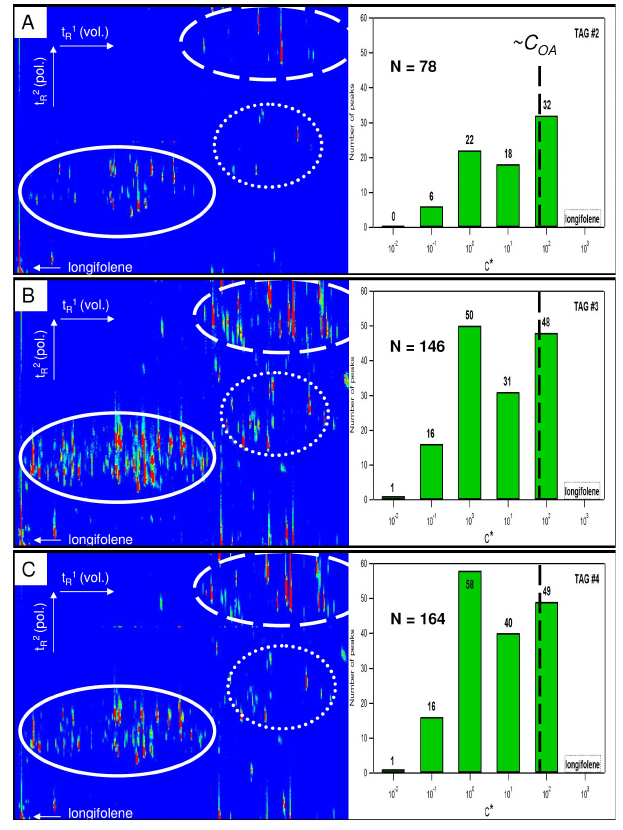
Fig. 6. GC × GC chromatograms and the number of peaks in each C ∗ bin in samples (A) TAG #2; (B) TAG #3; and (C) TAG #4. The x- and y-axes are t 1 (volatility separation) and t 2 (polarity separa- R R tion), respectively, and have the same scale as Fig. 3 (approximately ) . Color indicates detector 40 to 65min for t 1 and 0 to 5s for t 2 R R response (total ion chromatogram) in arbitrary units (blue is low- est, red is highest). Circled Region 1 (solid line) contains less oxy- genated, more volatile compounds while peaks in Regions 2 (dotted line) and 3 (dashed line) are thought to be more oxygenated, less volatile compounds and are discussed in detail in Section 3.2 of this text. Number of compounds in each C ∗ volatility bin is given on the right along with the total number of observed peaks. Aerosol mass concentration is shown as the line at C OA